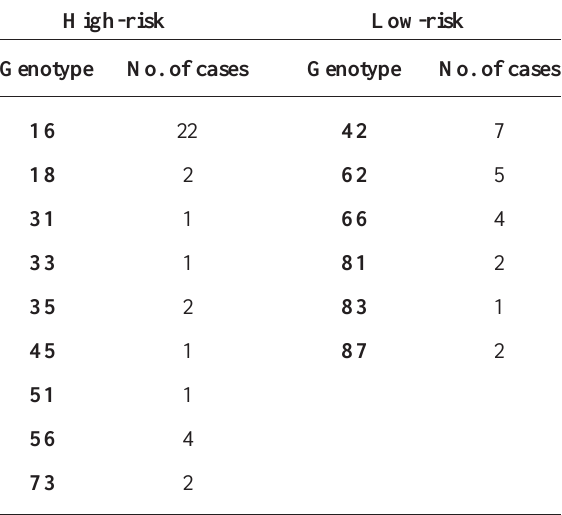
Table 1. High-risk and low-risk genotypes detected in the